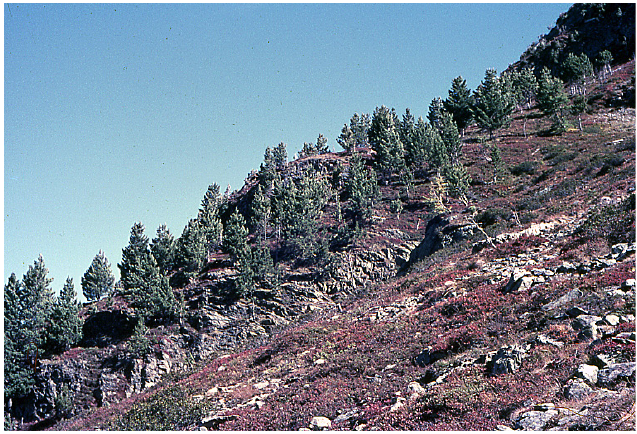
Figure 18: Swiss stone pines that were ‘planted’ by the European nutcracker ( Caryocatactes caryocatactes ) on convex topography at about 2270 m (Piz Rosatsch, Upper Engadine, Switzerland). Photo taken by the author, 23 September